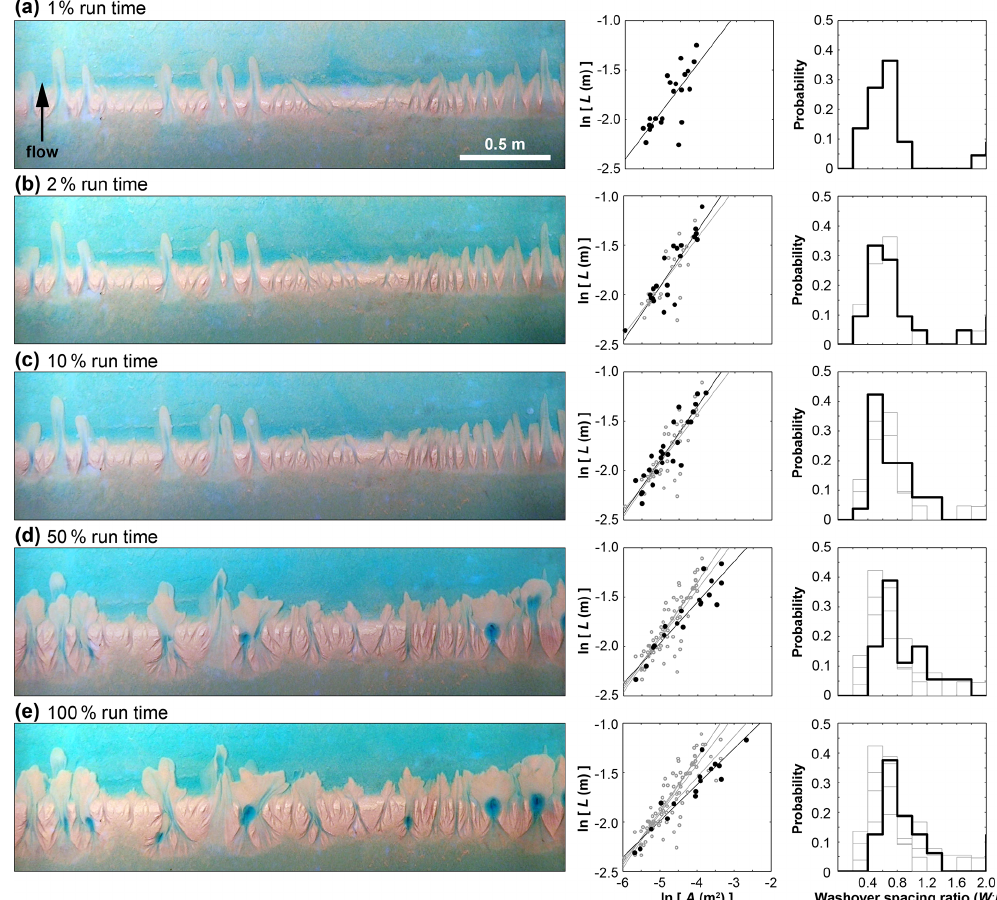
Figure 3. A demonstration of dynamic allometry in an experimental trial of overwash morphodynamics. Time is expressed as a percentage of the total run time; 100% run time reflects the final steady-state morphology. Overhead images of the experimental tank (left column) show, in snapshots, the washover morphology evolving as the trial progresses (a–e) . Log transform plots of washover length relative to area (middle column) show how the scaling exponent h changes through time. Data points and the fitted power relationship for a given image are plotted in black; data from previous snapshots are retained in grey. Stair plots (right column) track the related development of a preferred spacing ratio (calculated as W : L ), where the distribution at each snapshot is shown in black, and distributions from previous snapshots are retained in grey. Summary statistics are provided in Table